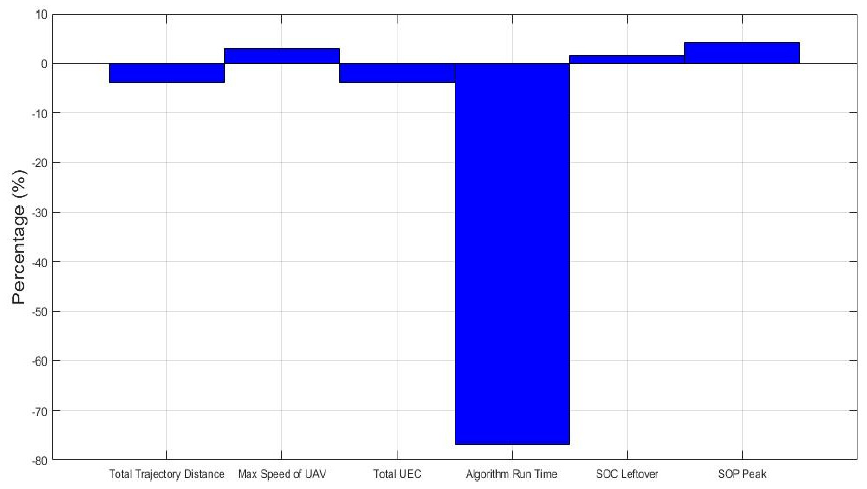
Figure 14. The comparison results in percentage (simulation).